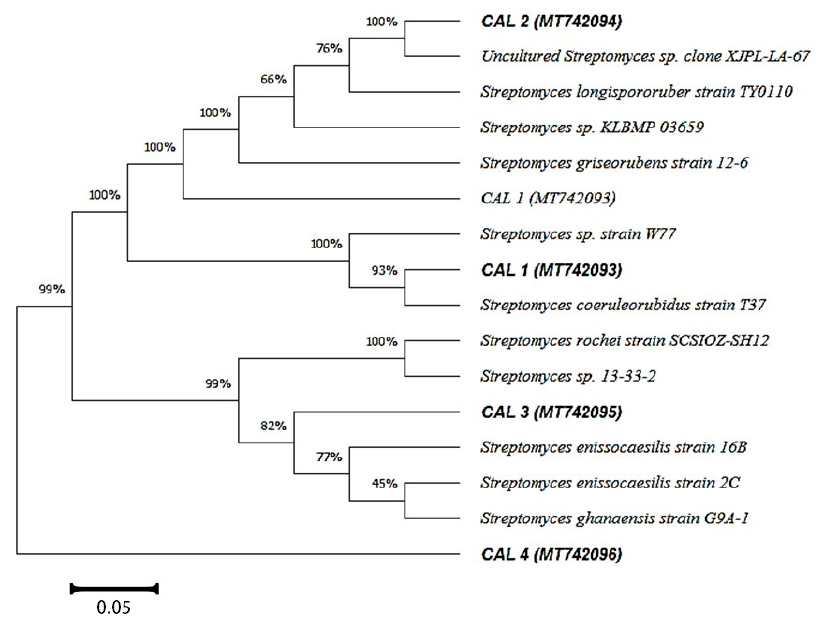
Figure 1. Neighbor-joining tree (partial sequences ~950 bp) showing the phylogenetic relationships of actinobacterial 16S rRNA gene sequences of potential strains to closely related (S ≥ 97%) se- quences from the GenBank